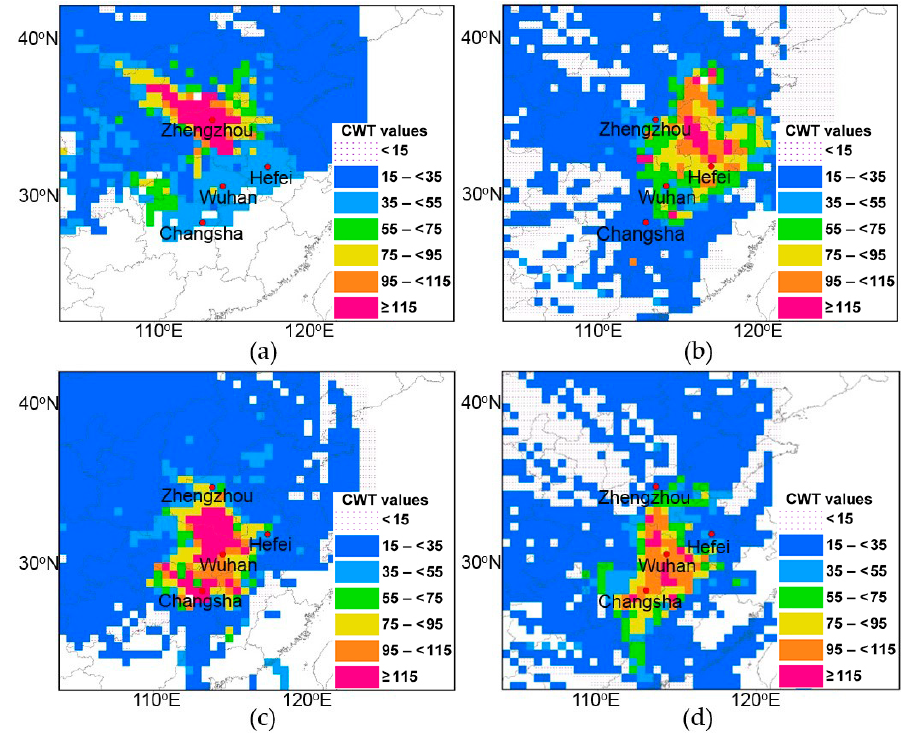
Figure 19. CWT method analysis maps for PM 2.5 in ( a ) Zhengzhou, ( b ) Hefei, ( c ) Wuhan, and ( d ) Changsha from 11 December 2014 to 26 February 2015.